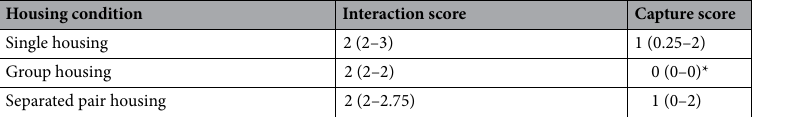
Housing condition